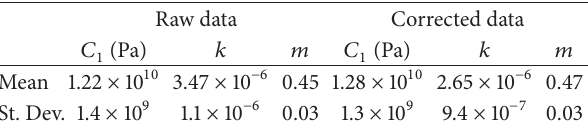
Table 2: Average data and standard deviations for the fitting parameters in the viscoplastic case before and after data correction. 𝐶